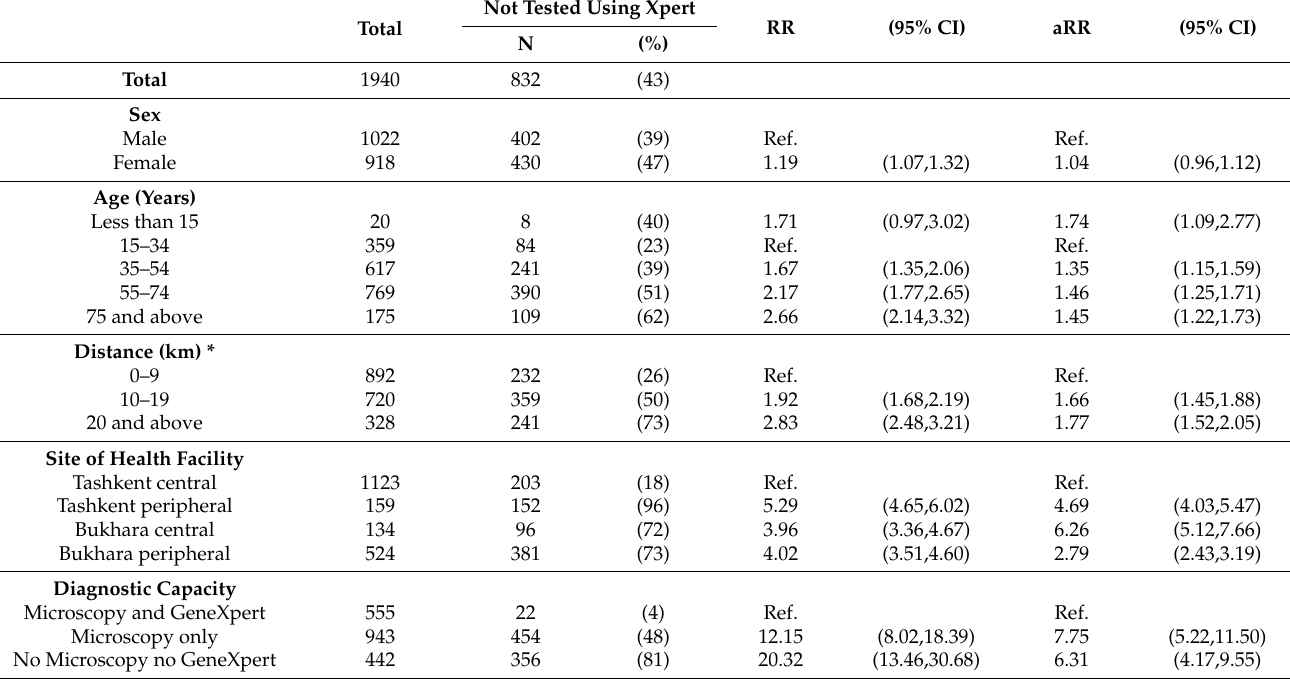
Table 4. Factors associated with not getting tested using the Xpert MTB/RIF assay among presumptive tuberculosis patients in selected health care facilities of Tashkent city and Bukhara region of Uzbekistan, January–March